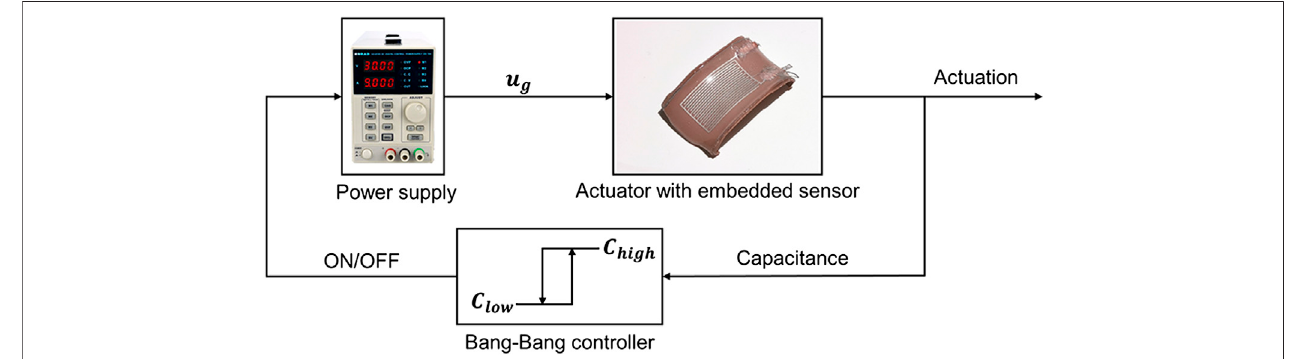
FIGURE 4 | Block diagram of the proposed controller. Both sides are implemented in partial actuation while only the higher bound is used in full actuation.